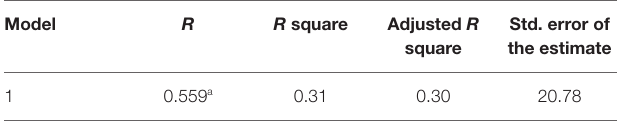
TABLE 5 | Model for the relationship among resilience, emotion regulation, and success. Model R R square Std. error of